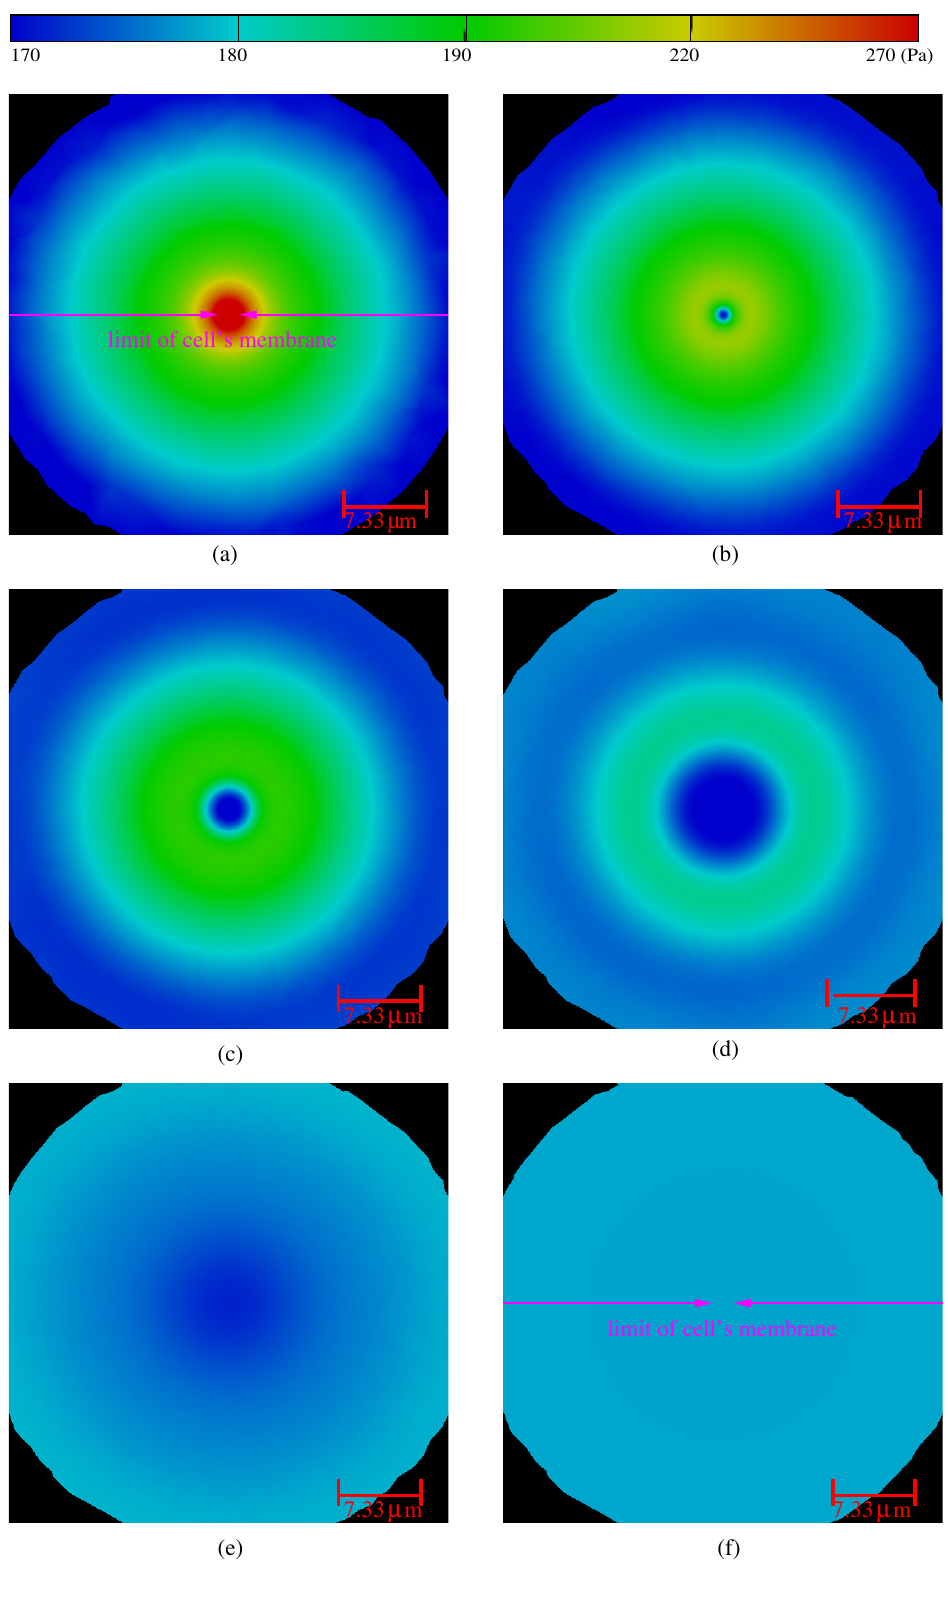
Figure 2. Time evolution of the variations of the acoustic pressure (in Pa) computed at ( a ) 0.5 ns; ( b ) 1.5 ns; ( c ) 2.5 ns; ( d ) 4.5 ns; ( e ) 14.5 ns and ( f ) 40.0 ns after the initial shock in the whole computationnal domain. The size of the cell’s membrane is also illustrated at the beginning and the end of the wave propagation ( a – f ). The radii of the nanoparticle, the cell and the computationnal domain are: 50 nm, 1 µ m and 22 µ m,